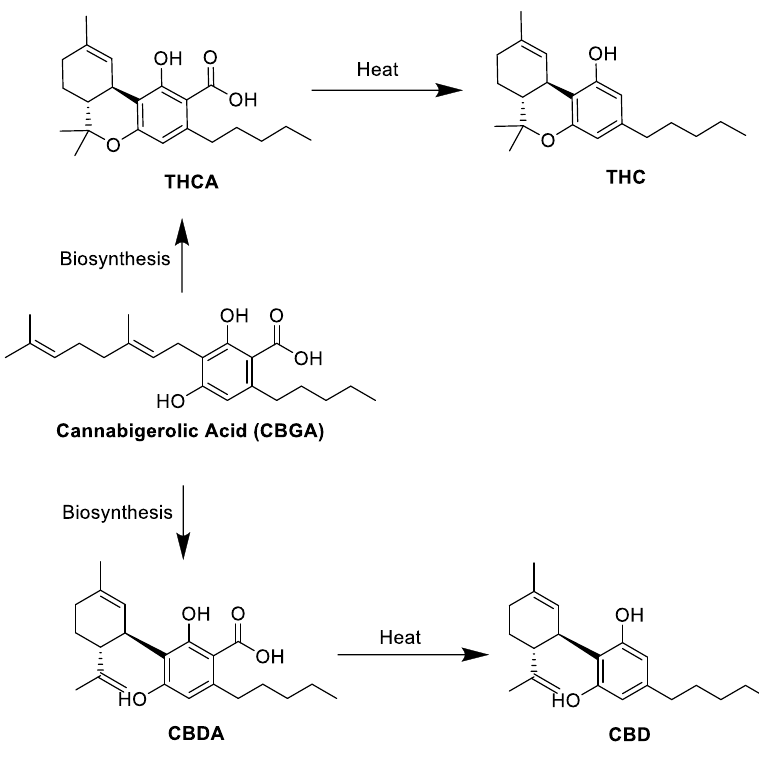
Figure 2. Biosynthesis of the acidic phytocannabinoids Δ 9 -THCA and CBDA and their decarboxylation into their active forms Δ 9 -THC and CBD.